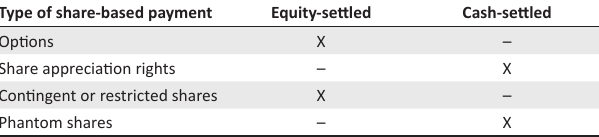
TABLE 3: IFRS 2 classifications of typical share-based payments to